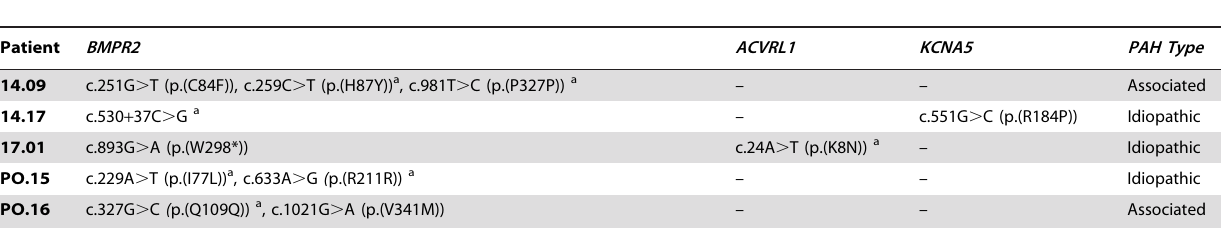
Table 6. List of patients with several pathogenic mutations in the studied genes.